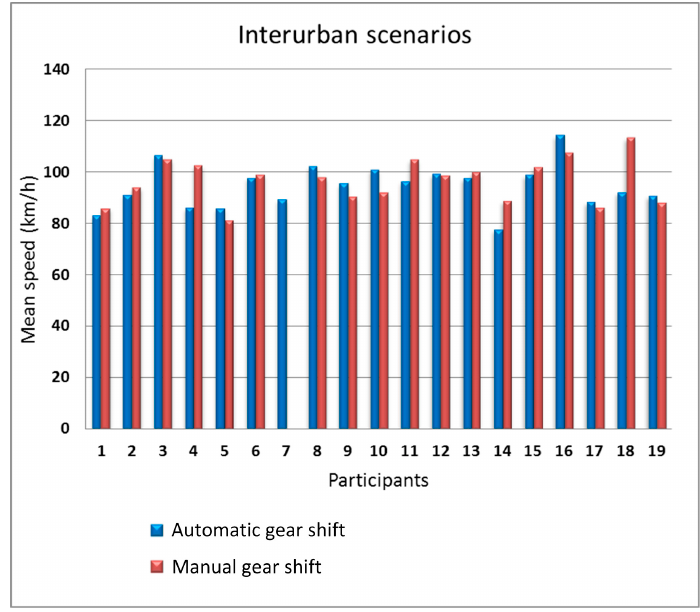
Figure 11. Mean speed as a function of the gear shift type in the interurban scenarios.